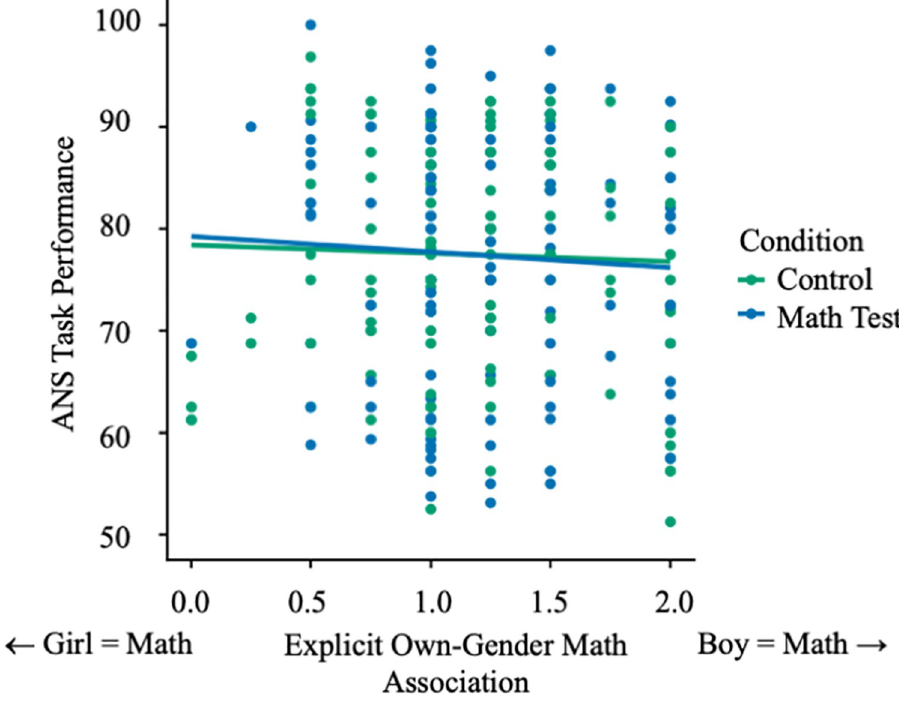
Fig 3. Boys’ ANS task performance by